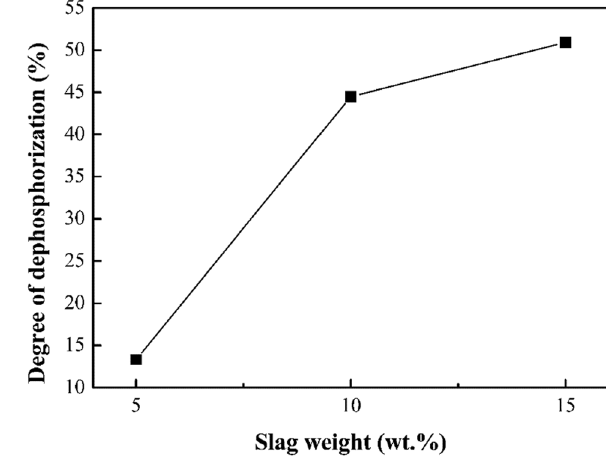
Figure 4: Relationship between dephosphorization e ffi ciency and rare earth oxide content.